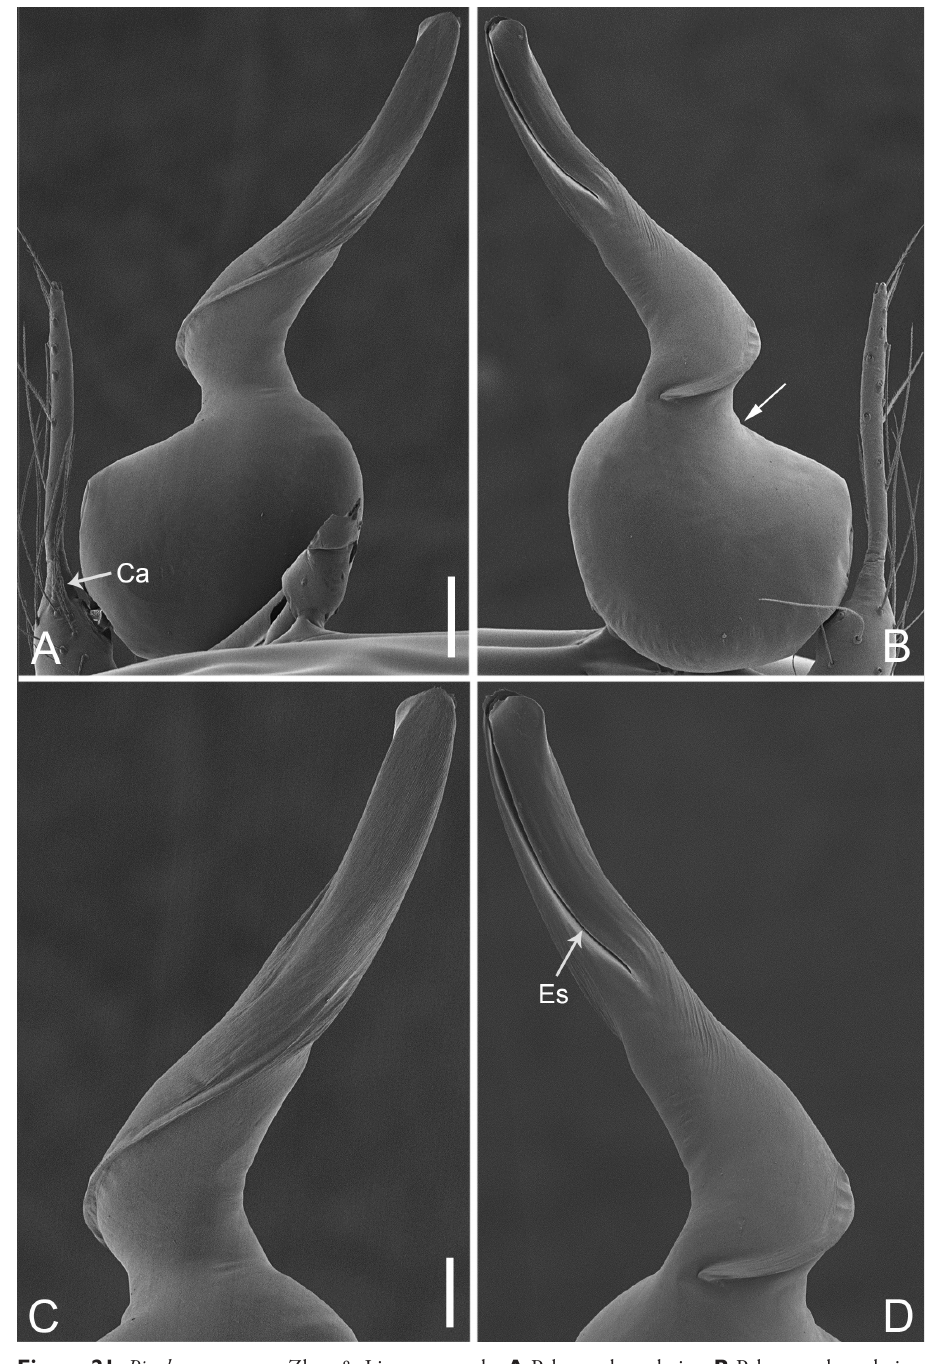
Figure 21. Pinelema wenyang Zhao & Li, sp. n., male. A Palp, prolateral view B Palp, retrolateral view C Embolus, prolateral view D Embolus, retrolateral view. Scale bars: 0.1 mm ( A–B ), 0.05 mm ( C–D